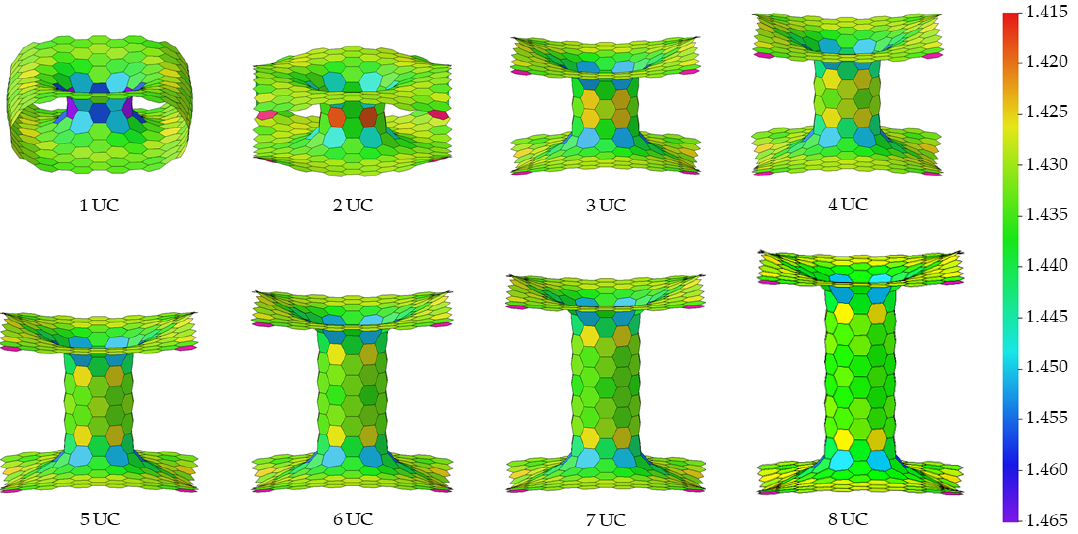
Figure 5. The MBL analysis of the 3D pillared C (6,6) nanostructures with various pillar lengths after full geometry optimization.